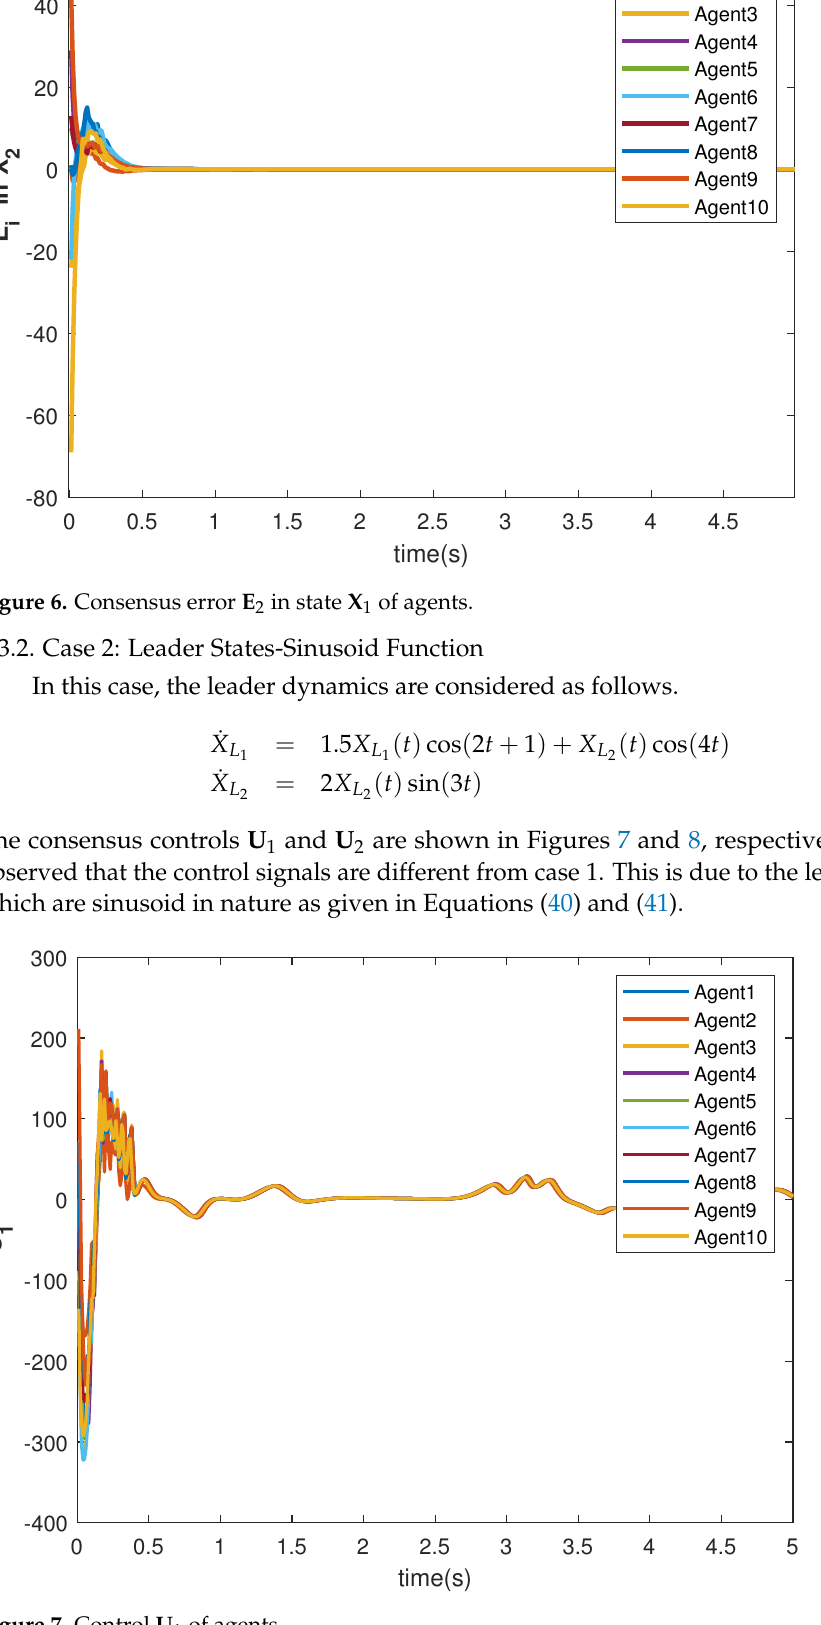
Figure 7. Control U 1 of